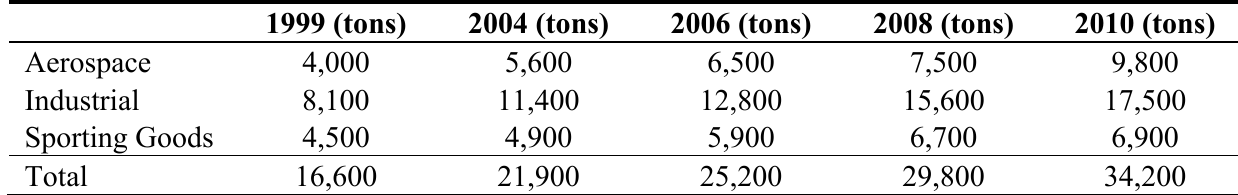
Table 1. Estimated global carbon fiber consumption [2,3].